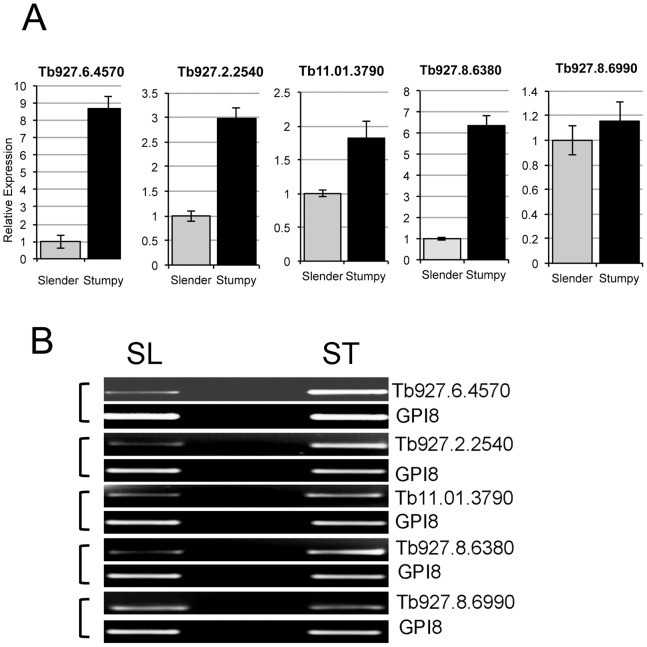
Validation of expression profiles detected by the transcriptome study.A. Realtime qRT PCR data for the relative expression of five transcripts predicted to be enriched in stumpy forms. mRNAs from slender and stumpy forms were subject to real time qRT-PCR using a constitutive transcript, GPI8, as a normalisation control. Although the scale of relative expression in each case differed from the global transcriptome study the direction of change, and the enrichment of each transcript in stumpy forms, was consistent, with the exception of Tb927.8.6990. B. qRT PCR products of the test transcripts in panel A, validating differential expression. In each case GPI8, which does not show statistically significant variation between life cycle stages, provided the normalisation control [58].